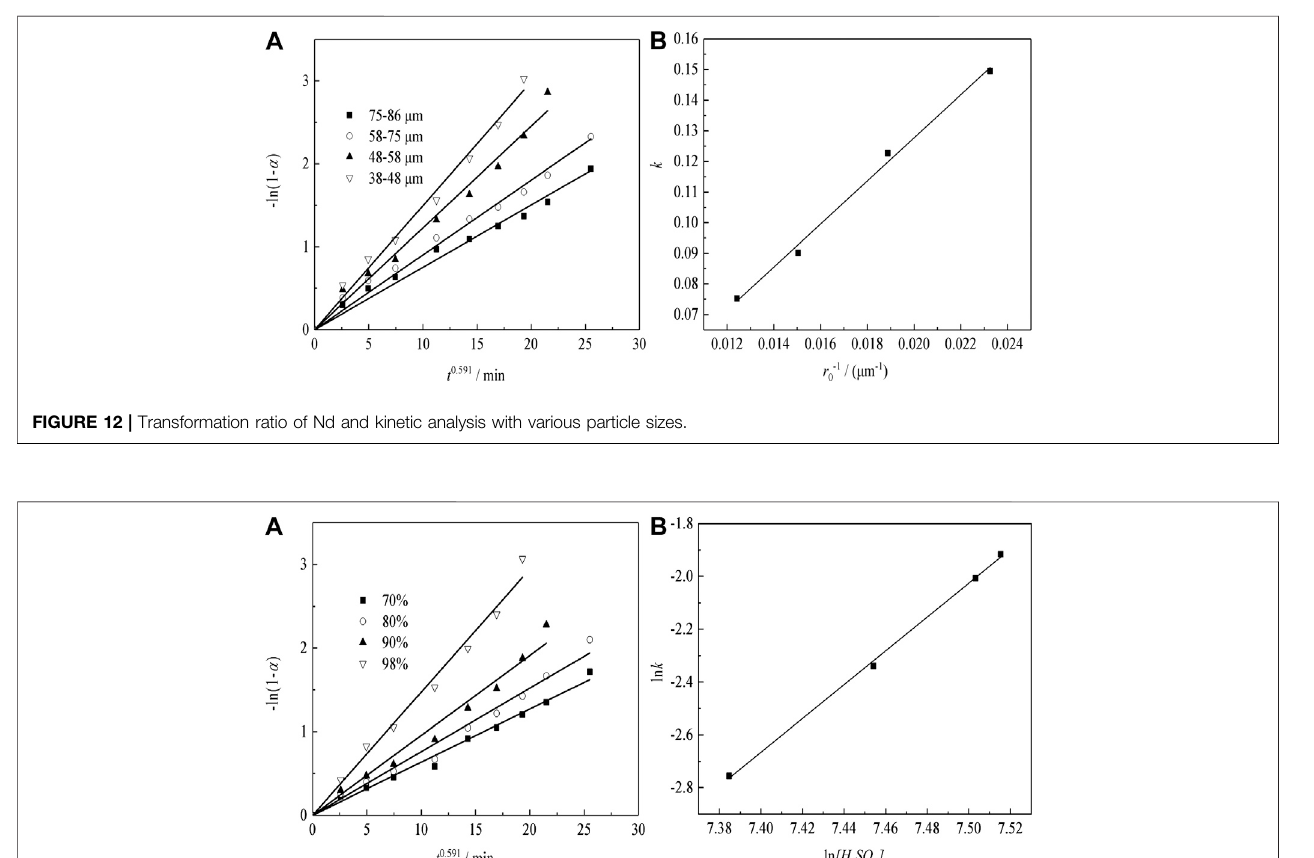
Frontiers in Chemistry |